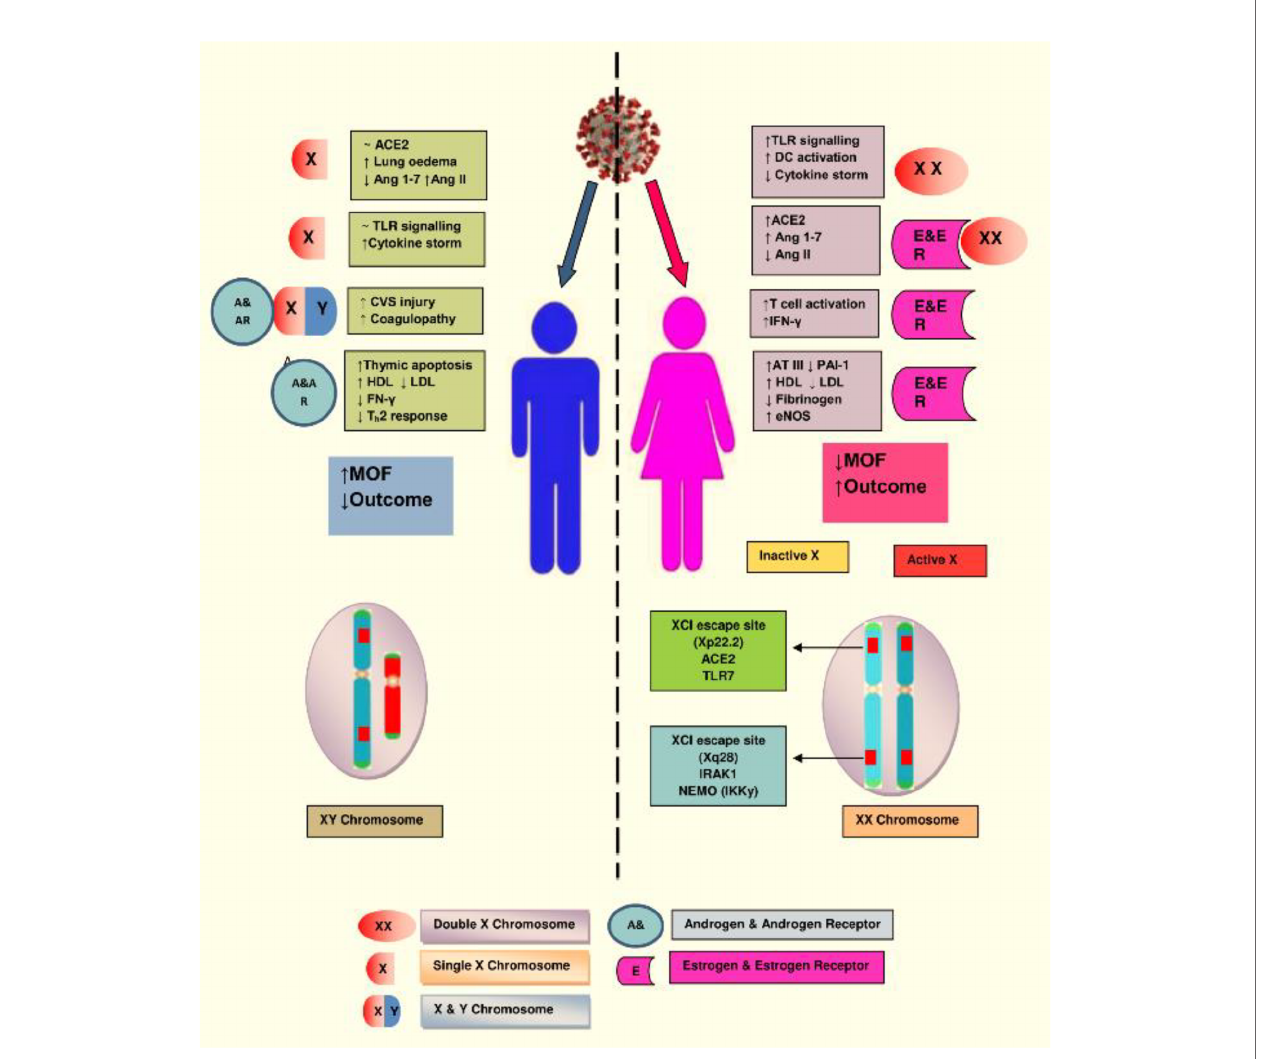
FIGURE 3 | The X chromosome in females has various genes associated with immunity. Natural mutation in one copy of X gene may lead to two different alleles with distinct regulatory mechanism, which protect the women from implications of deleterious mutations and confers advantage in facing novel immunogens, like SARS-CoV-2. Illustration presents the genes encoded on the X-chromosome involved in the increased immune response in females during COVID-19. (Abbreviations used: TLR7, Toll-like receptor 7; DC, dendritic cell; CVS, cardiovascular system; IFN- g , interferon gamma; LDL, low-density lipoprotein; HDL, high-density lipoprotein; ATIII, antithrombin III; IRAK1, Interleukin-1 receptor-associated kinase 1; MOF, multiorgan